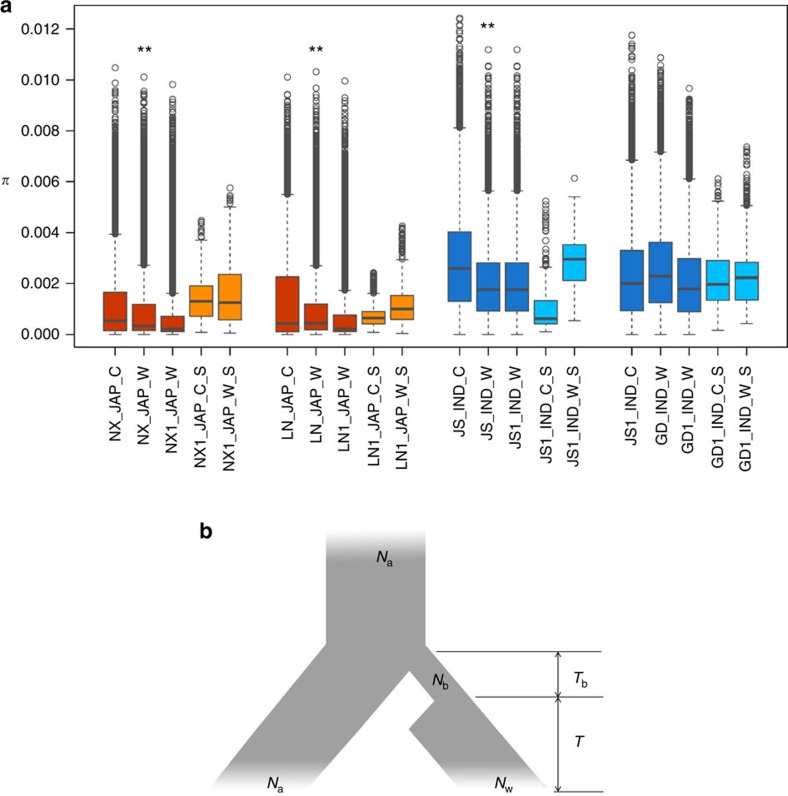
Genetic diversity and demographic model for weedy rice.(a) Boxplots of genetic diversity (π) for weedy and cultivated rice. Boxes with orange colour are japonica type (JAP), and blue for indica type (IND). Cultivated rice is labeled with ‘_C', whereas weedy rice with ‘_W'. Genetic diversity for significant divergent windows of weedy from cultivated rice are marked in light orange or blue colour with the suffix ‘_S'. The prefixes ‘NX', ‘LN', ‘JS', ‘GD' are short for Ningxia, Liaoning, Jiangsu and Guangdong provinces, respectively. The prefixes ‘NX1', ‘LN1', ‘JS1', ‘GD1' are short for main de-domestication origin of Ningxia, Liaoning, Jiangsu and Guangdong provinces, respectively. The ‘**' is marked if the genetic diversity of weedy rice is significantly lower than that of local cultivated rice (P<0.01 by paired t-test). (b) Demographic model for weedy rice. The model assumes that the initiate weedy rice founders split from cultivated rice (effective population size Na) and then suffered a genetic bottleneck in a Tb duration. After the bottleneck, the weedy rice founder population (effective population size Nb) recovered to the present effective population size (Nw) at time T.